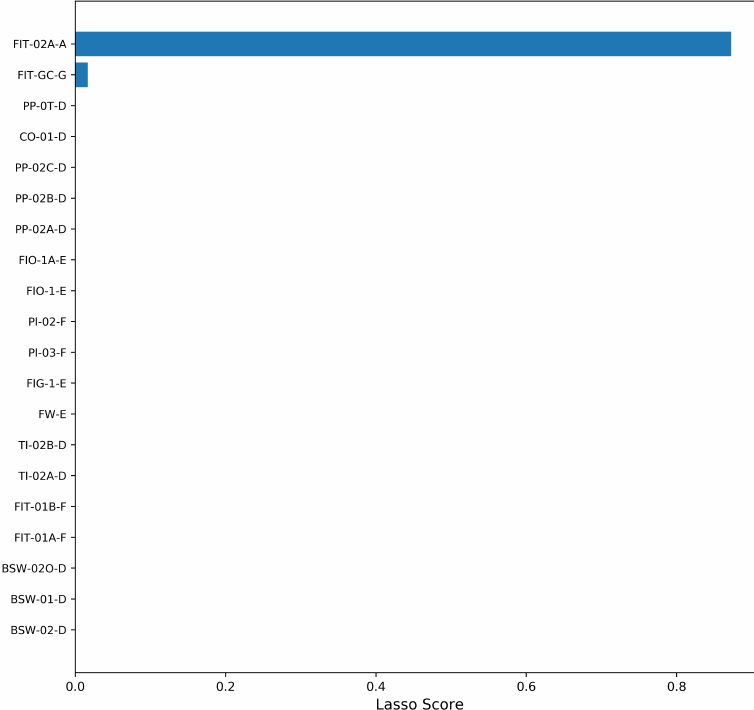
Figure A11. Variables subset for Fault F-I detection selected by the L1-regularization (Lasso) method.